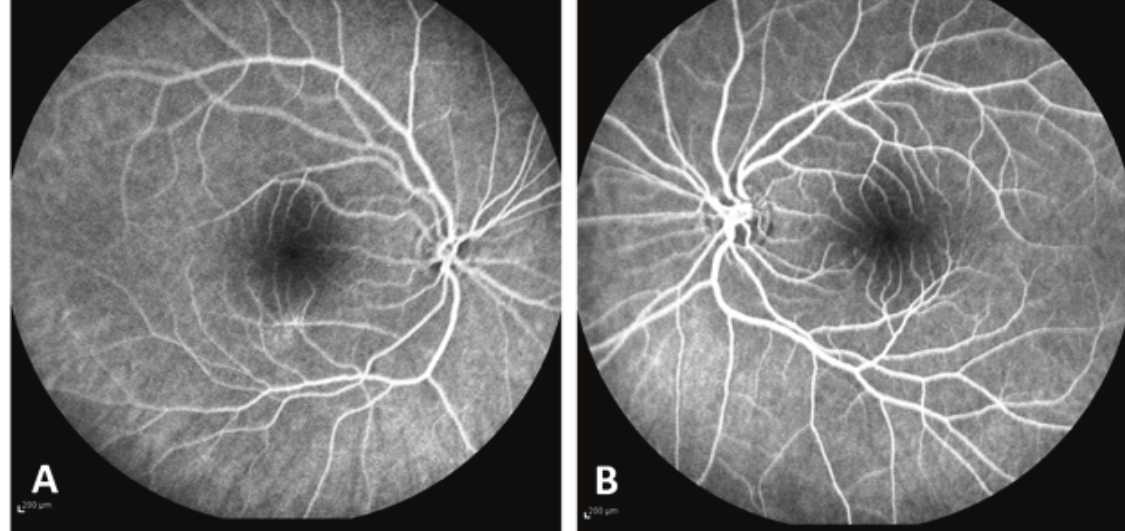
Figure 3. Fluorescein angiography of the right (A) and left (B) eyes showing a small capillary-free zone in each eye, with almost normal masked fluorescence in the macular area due to the presence of the macular